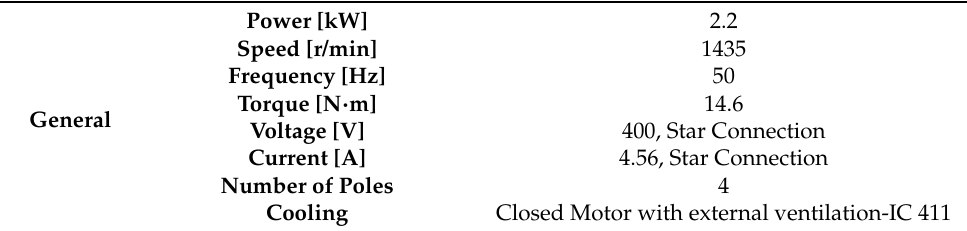
Table 1. Induction motor technical parameters.